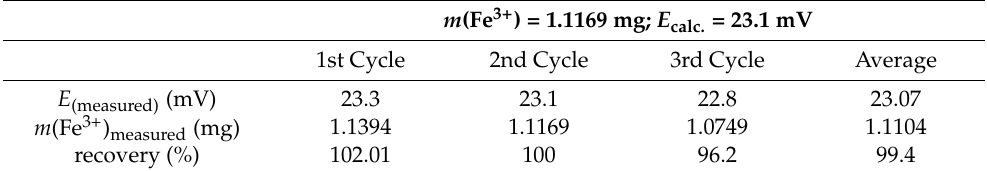
Table 6. Test results for MN1 in standard solution for m (Fe 3+ ) = 1.1169